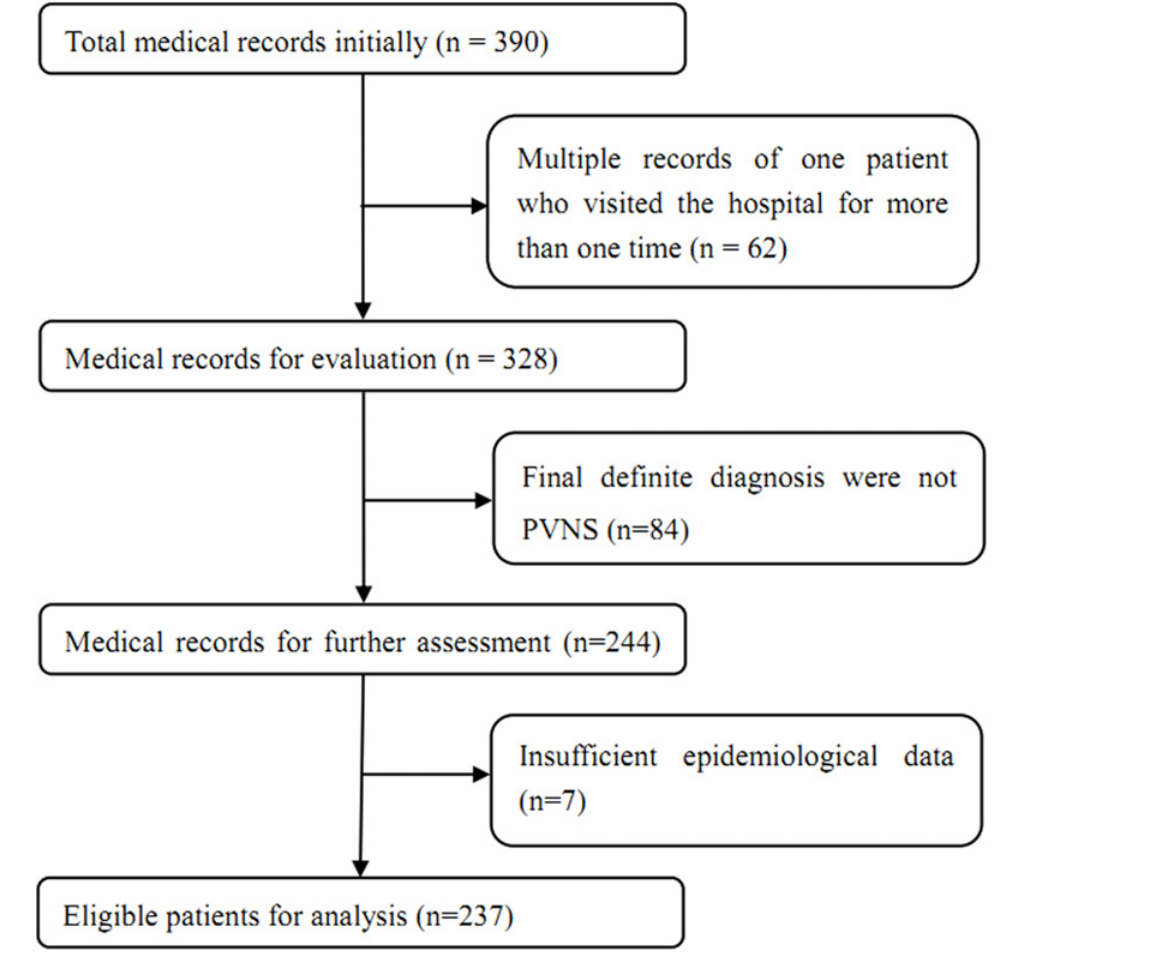
Fig 1. Flow chart of eligibility